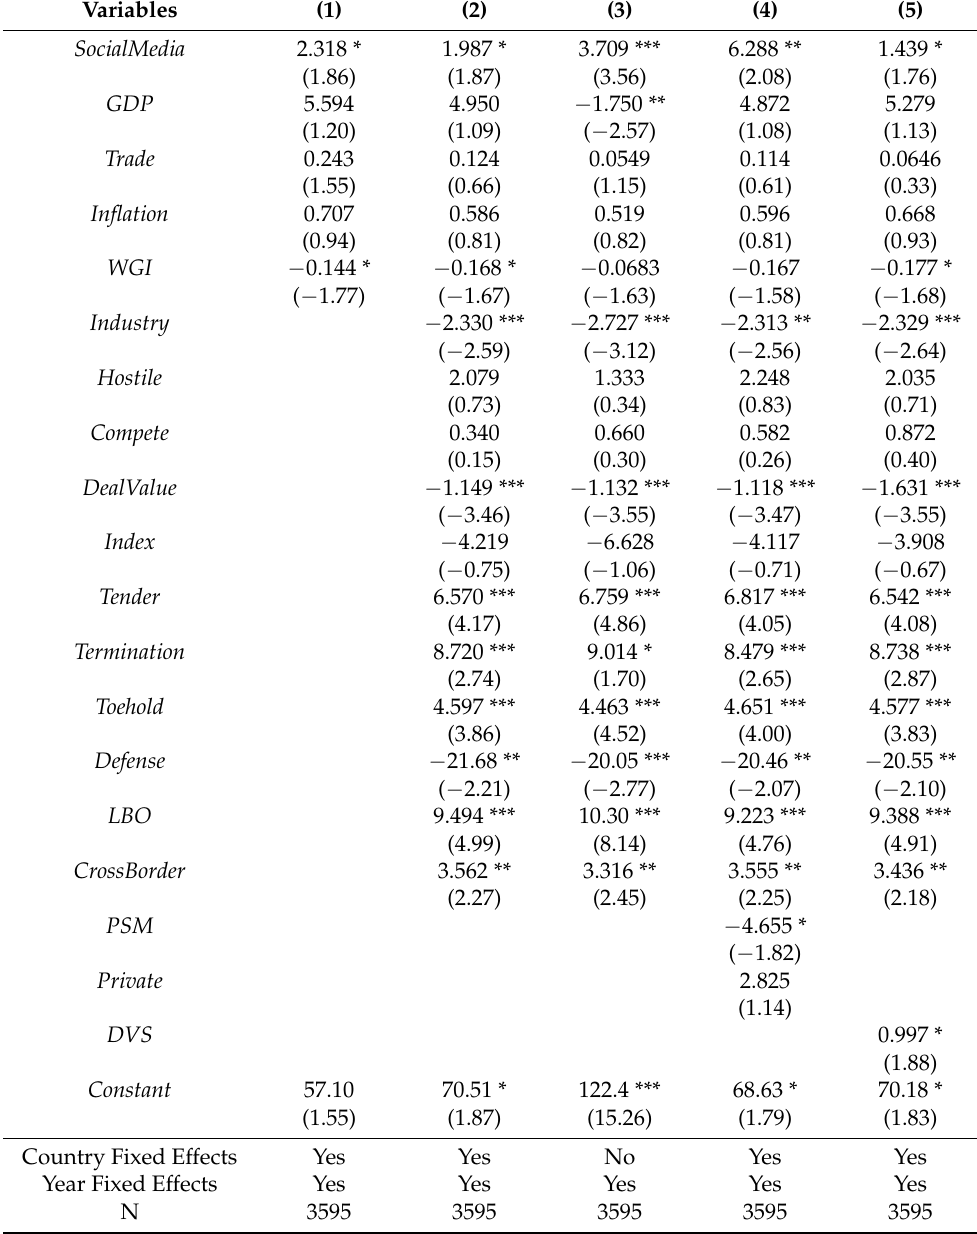
Table 11. Proportion of cash paid as consideration for the emerging market subsample. To be included in the subsample, neither the acquiror nor target are domiciled in one of the top ten M&A markets by volume for the full period. This table presents the results of five panel fixed-effects regressions for the subsample of active market M&A deals. The dependent variable is CashPaid, the percentage of cash included in the payment for the M&A transaction. The main independent variable is SocialMedia, an indicator variable that equals 1 if social media is popular in country j at time t. Control variables are the same as described previously. Standard errors are double clustered by country and